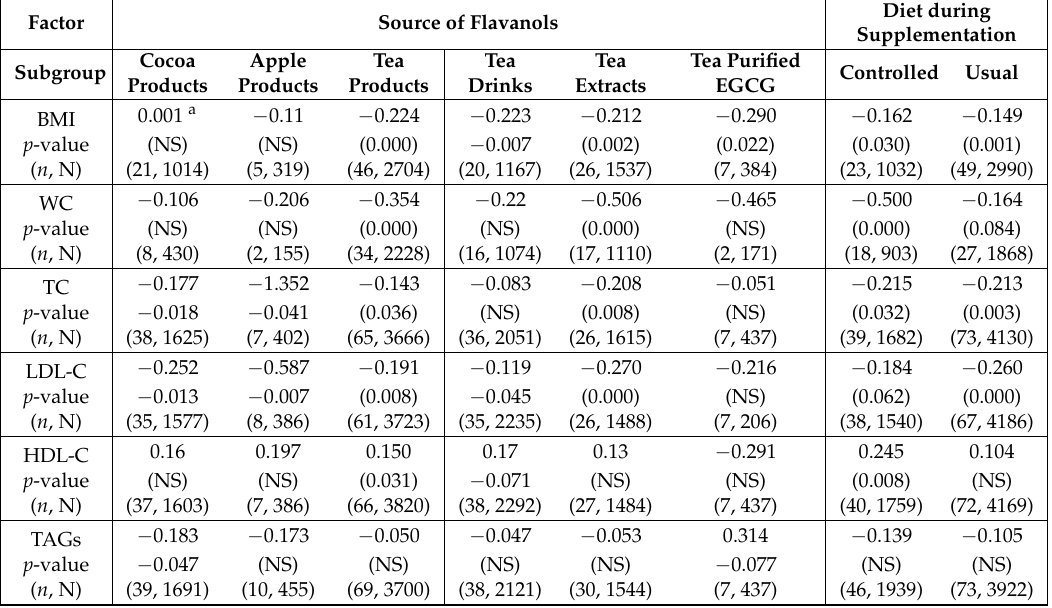
Table 5. Analysis of the influence of the original source of flavanols and of the diet (during the intervention) on the effects (SDM) of the supplementation on BMI, WC, and blood lipids